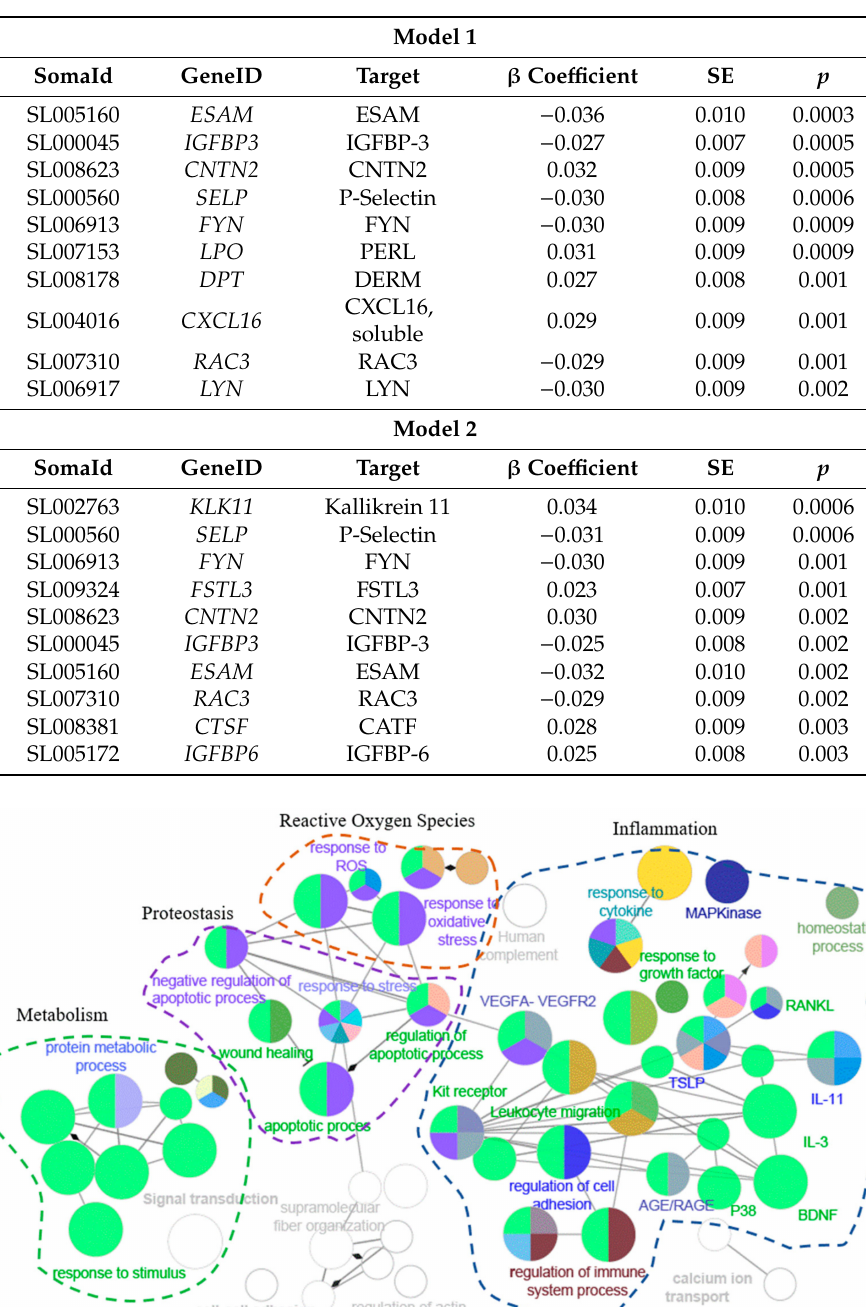
Table 3. Top-10 most significant SOMAmers associated with τ PCr , an inverse measure of mitochondrial oxidative capacity, adjusting for age, sex, and amount of phosphocreatine depletion (Model 1); top-10 most significant SOMAmers associated with τ PCr adjusting for age, sex, phosphocreatine depletion, BMI, and race (Model 2).